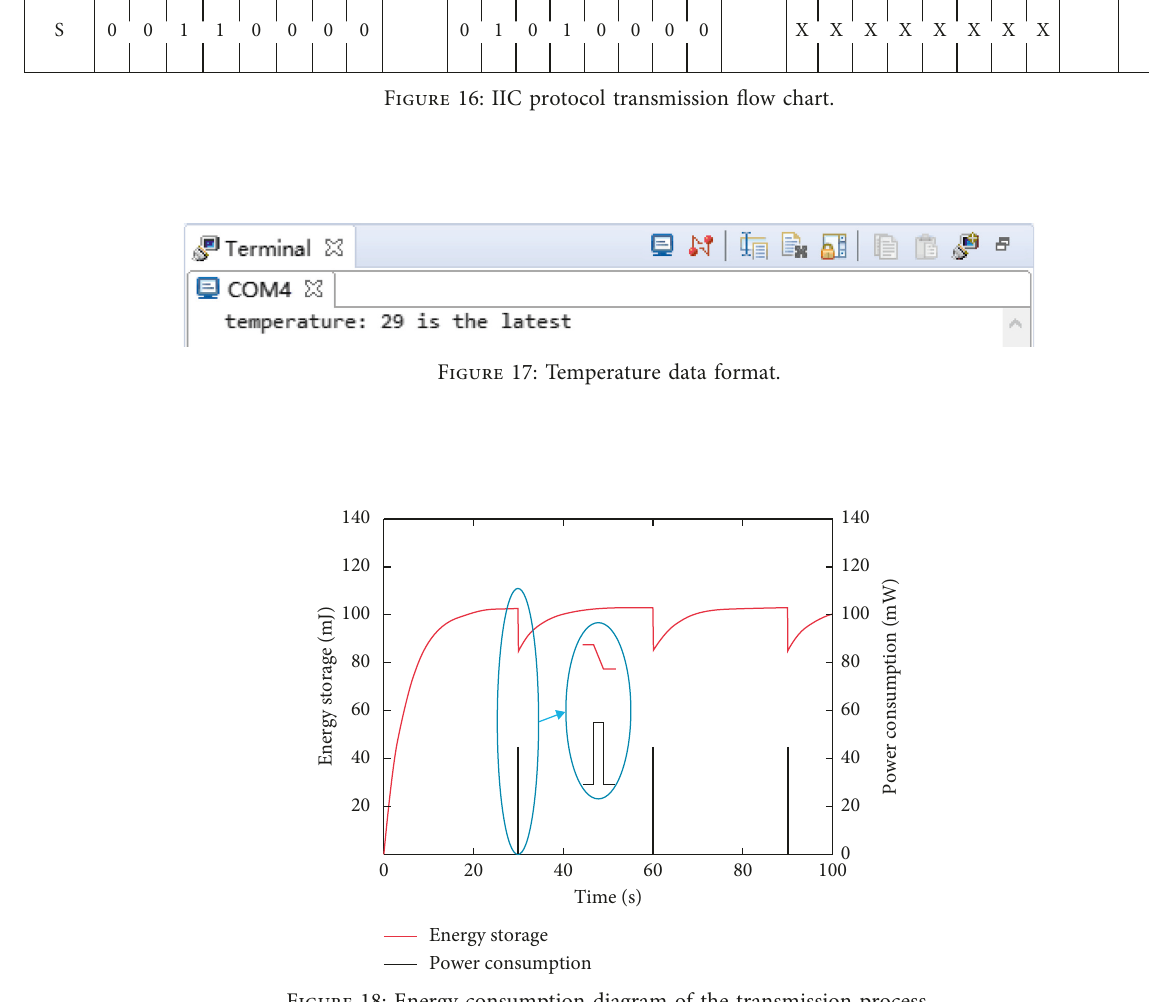
Figure 18: Energy consumption diagram of the transmission process.